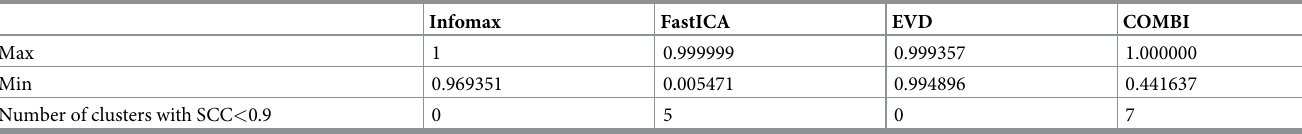
Table 8. Range of SCC values between the most reliable ICASSO results and the other nine results (sensory data).